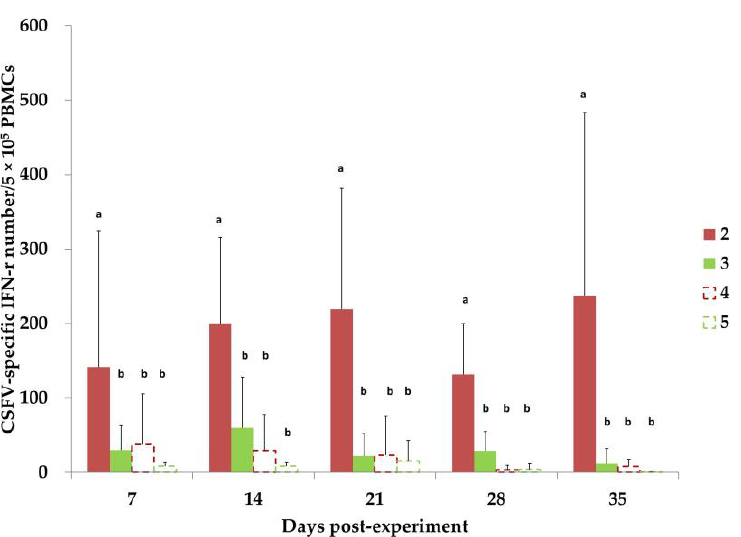
Figure 4. CSFV-specific IFN- γ -secreting cells examined in the PBMCs of piglets in Groups 2 to 5 between 7 and 35 DPE. The piglets in Group 2 with LPC vaccination at 0 DPE and those in Group 3 without LPC vaccination cohabited with the Group 1 CSFV donor piglet from 7 to 17 DPE. The piglets in Groups 4 and 5 cohabited with those in Groups 2 and 3, respectively, from 17 to 35 DPE. Values with different superscript letters, a and b, indicate a statistically significant difference ( p < 0.05) from each other. No significant differences exist between values containing the same letter.